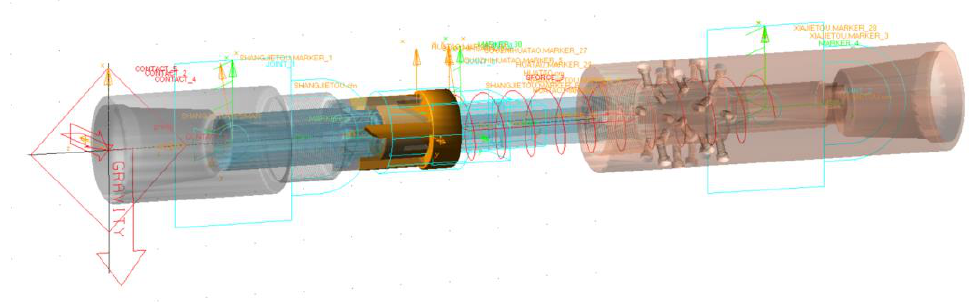
Figure 4. Dynamic simulation model of PJCT.